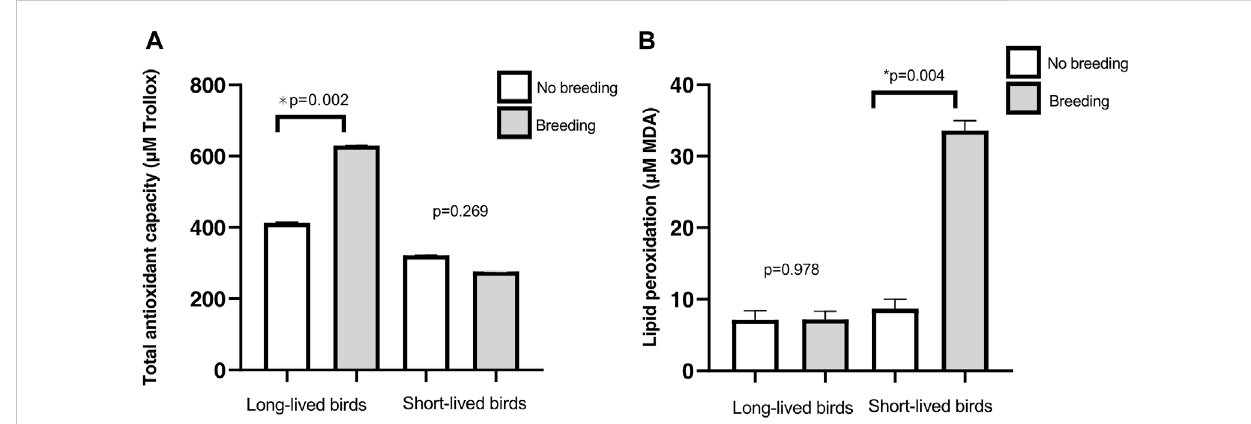
FIGURE 6 Markers of oxidative stress in relation to reproduction. (A) Total antioxidant capacity (mean of µM Trolox equivalents ±SD) in long- and short-lived birds with different breeding status. A three-way ANOVA was conducted to determine the effects of sex, longevity and reproduction. (B) Lipid peroxidation products (mean of µM MDA ± SD) in long- and short-lived birds with different breeding status, conducted by a two-way